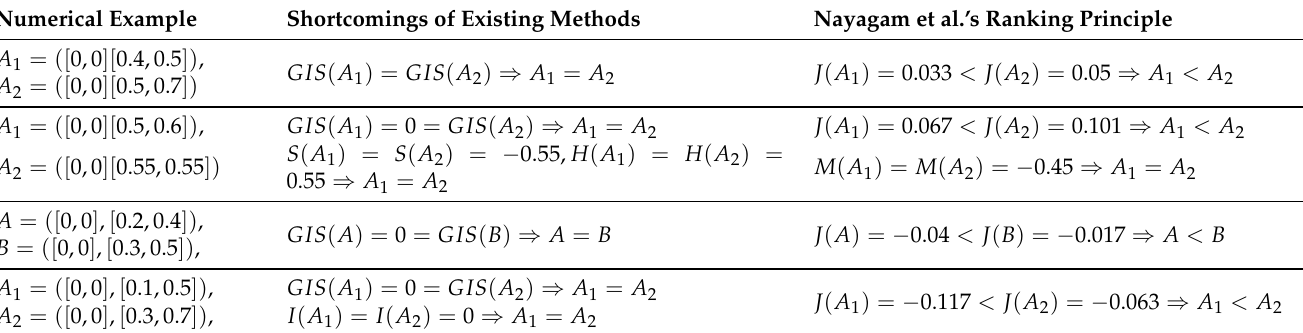
Table 1. Comparison of some existing score functions with Nayagam et al.’s [10] approach. Numerical Example Shortcomings of Existing Methods Nayagam et al.’s Ranking